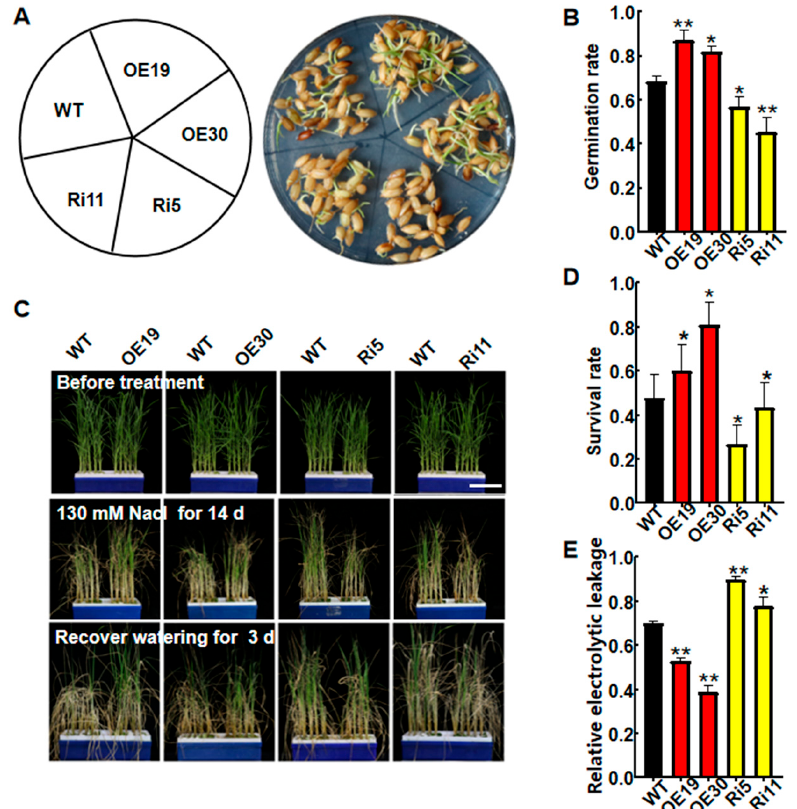
Figure 3. Analysis of salt tolerance in WT and OsASR6 transgenic seedlings. ( A ) Phenotypes of wild-type (WT) and transgenic lines following 100 mM NaCl treatment for 4 d. ( B ) Germination rates of WT and OsASR6 transgenic plants following 100 mM NaCl treatment for 4 d. Data represent means ± SD ( n = 30). ( C ) Phenotypes of all tested rice plants before and after salt treatment, and after re-watering. Four-week-old seedlings were used for salt treatment (bar = 5 cm). ( D ) Survival rates and ( E ) relative ion leakage following NaCl treatment for 4 d. Asterisks indicate significant differences between means of WT and transgenic lines. Three independent experiments were carried out with similar results. Data represent means ± SD. * p < 0.05, ** p <